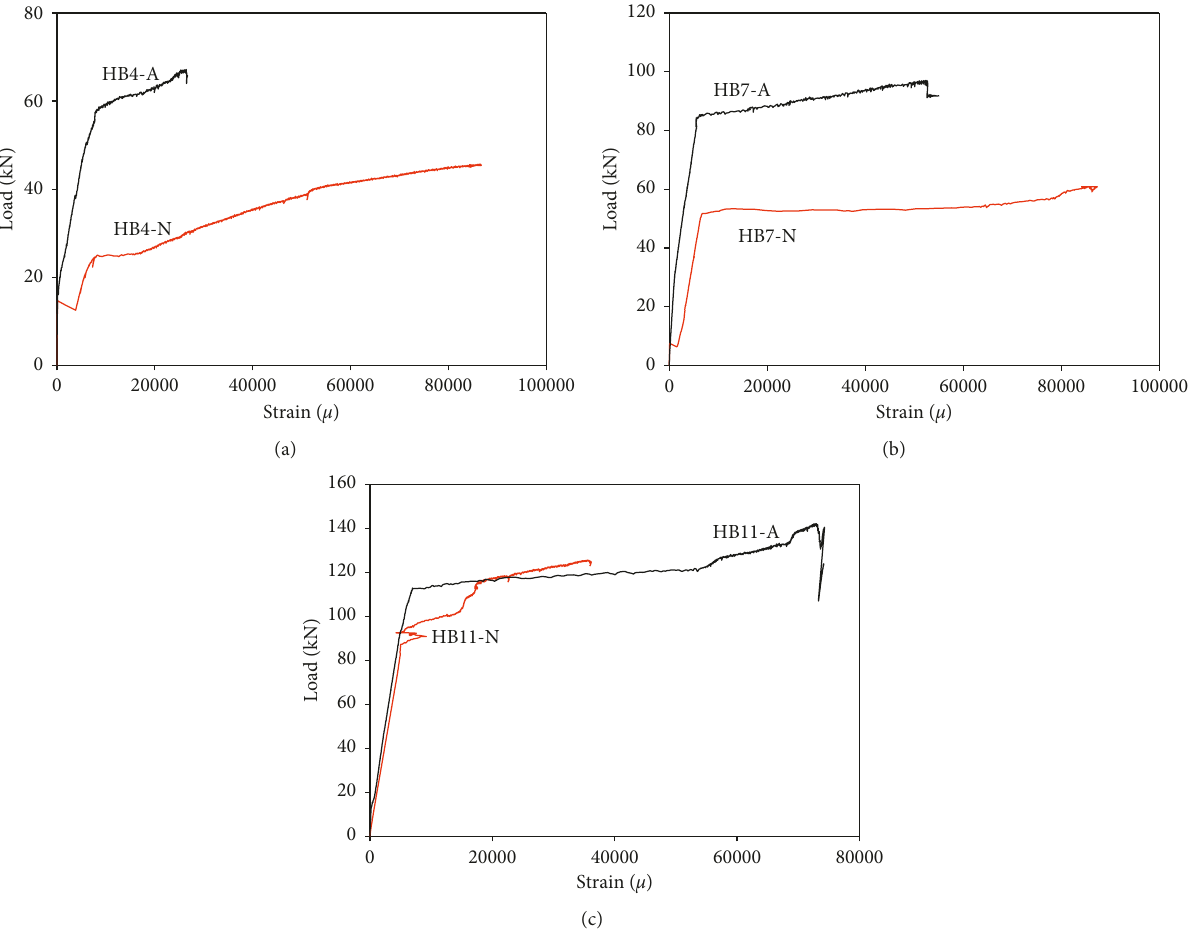
Figure 15: Load-steel strain curves of UHPC flexural specimens. Table 16: Initial crack load and ultimate load and ductility of UHPC flexural specimens. Yield (kN) Initial crack load, P cr